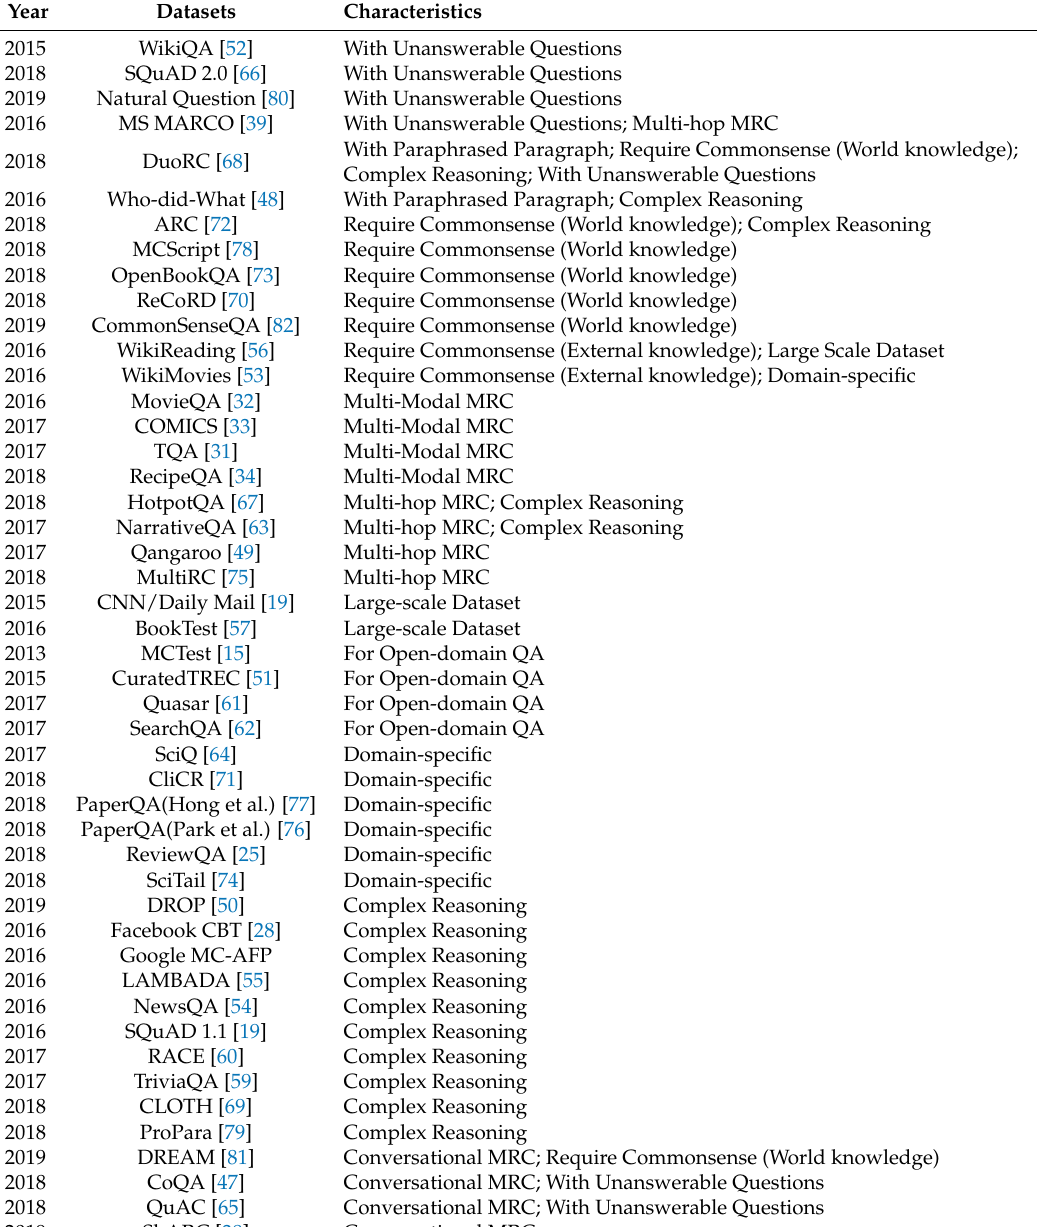
Table 10. The characteristics of each MRC